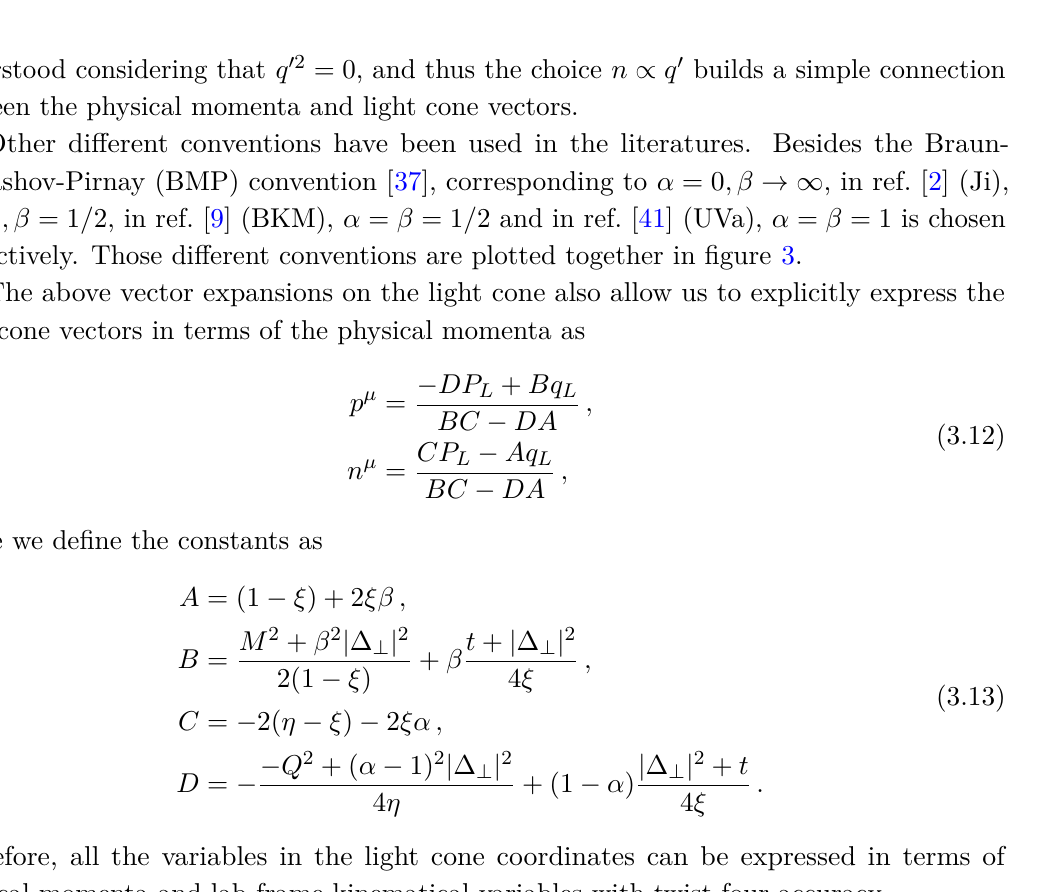
Figure 3 . A plot illustrating that different conventions in the literatures corresponds to different choice of α and β